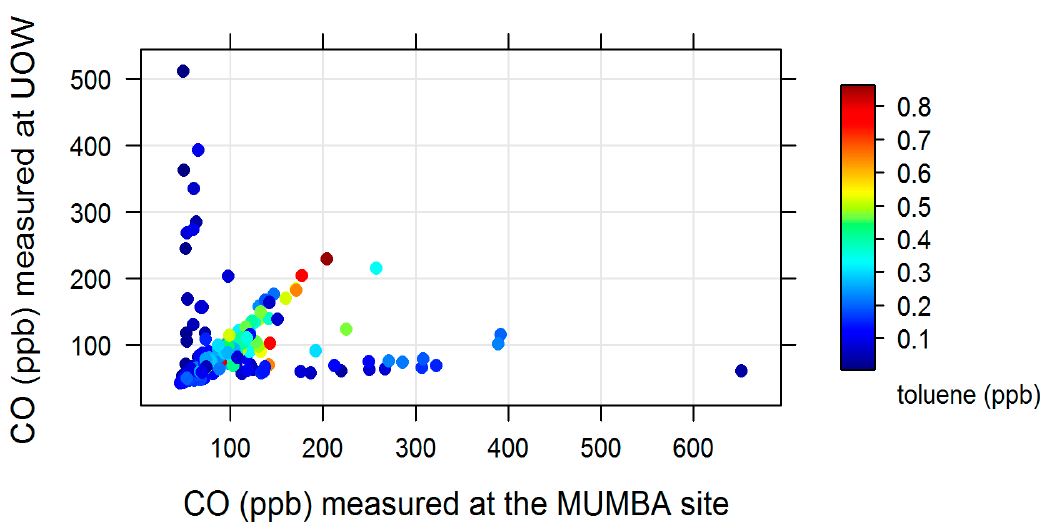
Figure A1. CO measured at the University of Wollongong (UOW) site plotted against coincident CO measured at the main MUMBA site. Data points are coloured by toluene concentration measured at the MUMBA site.